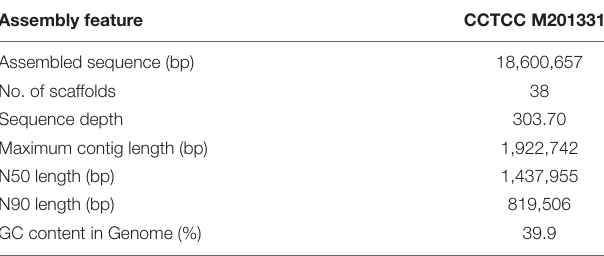
TABLE 3 | The assembly of the genome for strain M2013310.